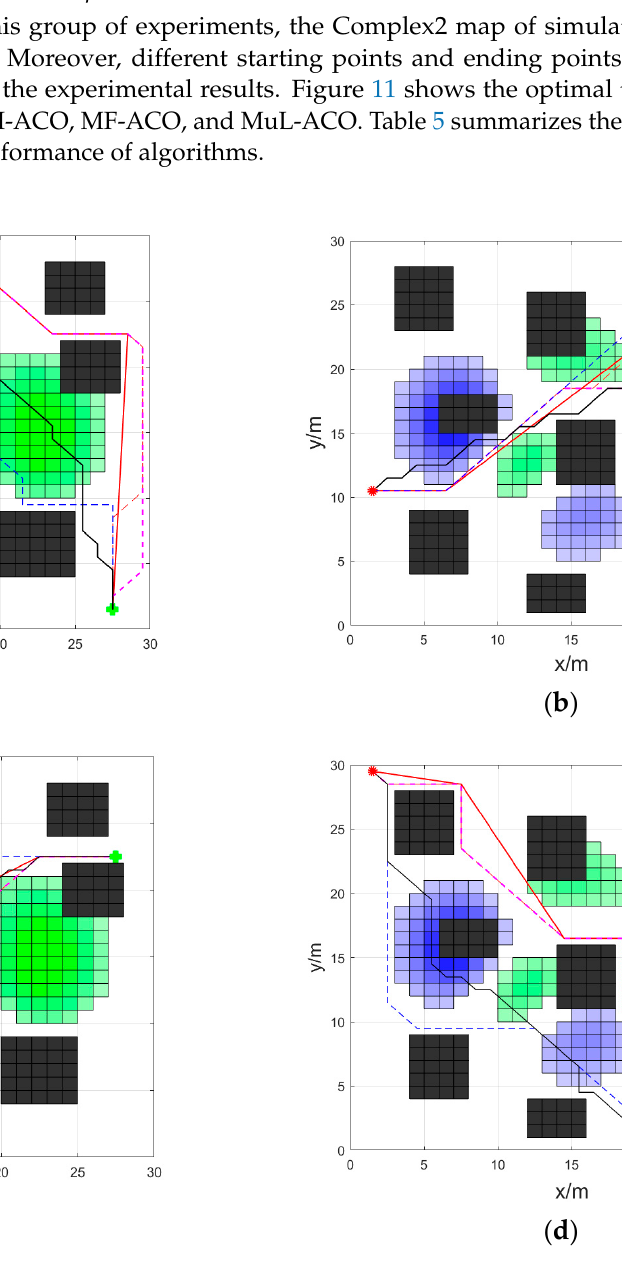
Figure 11. ( a – d ) The trajectories are generated by ACO, MH-ACO, MF-ACO, and MuL-ACO on the map with different starting points and ending points. Table 5. Simulation results of ACO, MH-ACO, MF-ACO, and MuL-ACO on the map with different starting points and ending points.